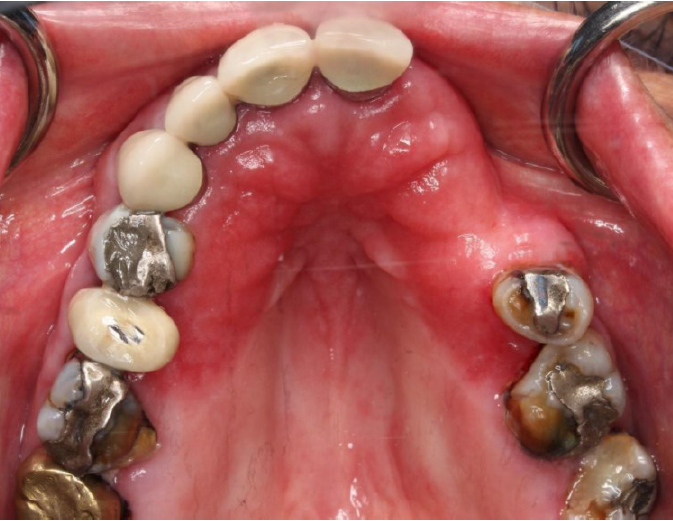
Figure 5. Clinical manifestation of Candida albicans sp. fungal infection characterized by the redness (erythema) on the denture base adaptation (saddle) area. In this case, the disease was precipitated by the Sjogren Syndrome due to the low quantity and quality of saliva.